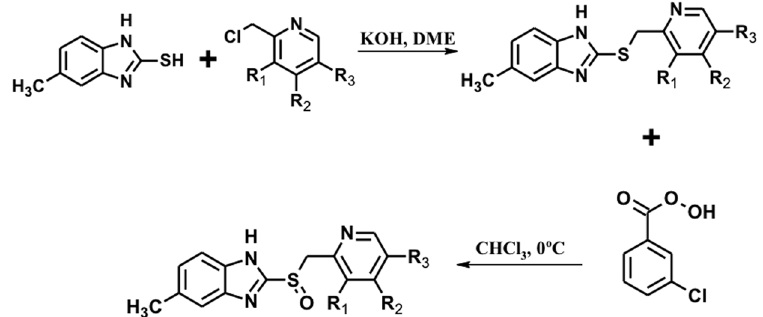
Figure 2. Synthesis of novel compounds. The structures were performed by using ChemSketch software